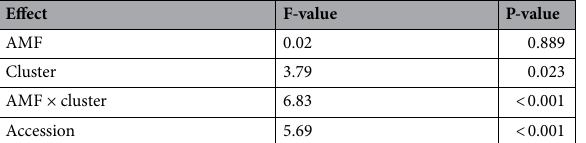
Table 3. Nested ANOVA results of the effect of arbuscular mycorrhizal fungal isolates (AMF), Triticum turgidum clusters and accession, on plant shoot dry weight.